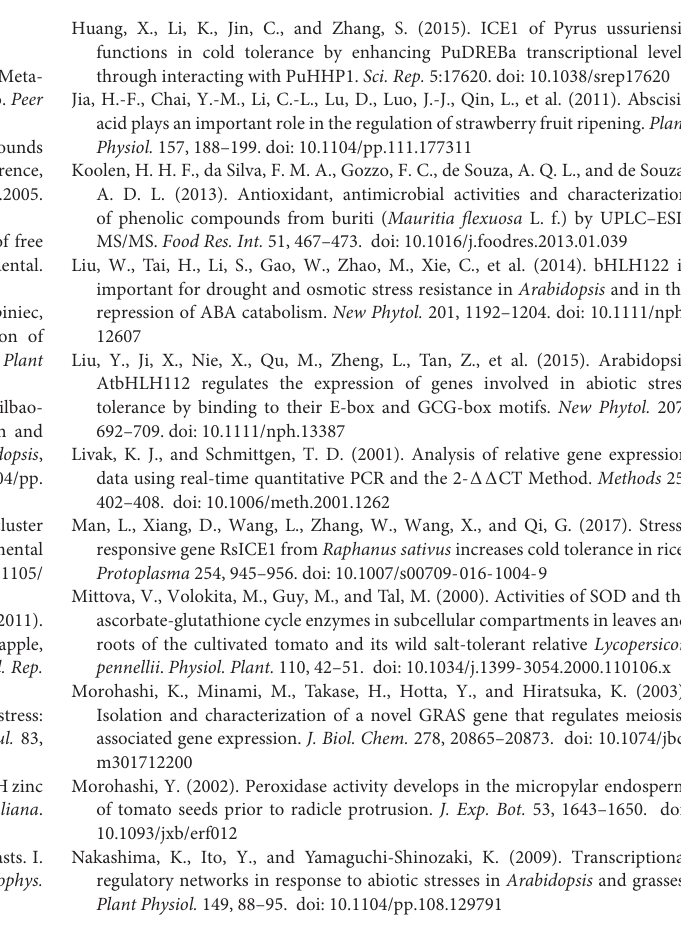
FIGURE S1 | In silico bioinformatics analysis of SlbHLH22 protein interaction network predicted using STRING program.